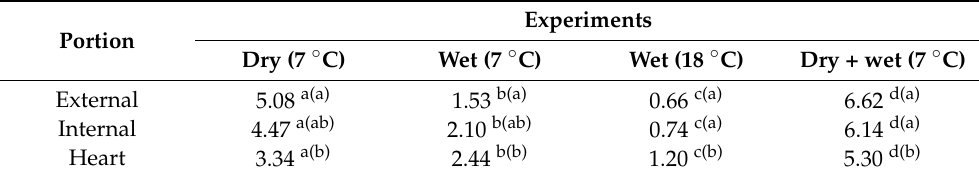
Table 4. NaCl concentration (%) after dry salting, manual injection, wet salting, and dry + wet salting stored for one week at 7 ◦ C and 18 ◦